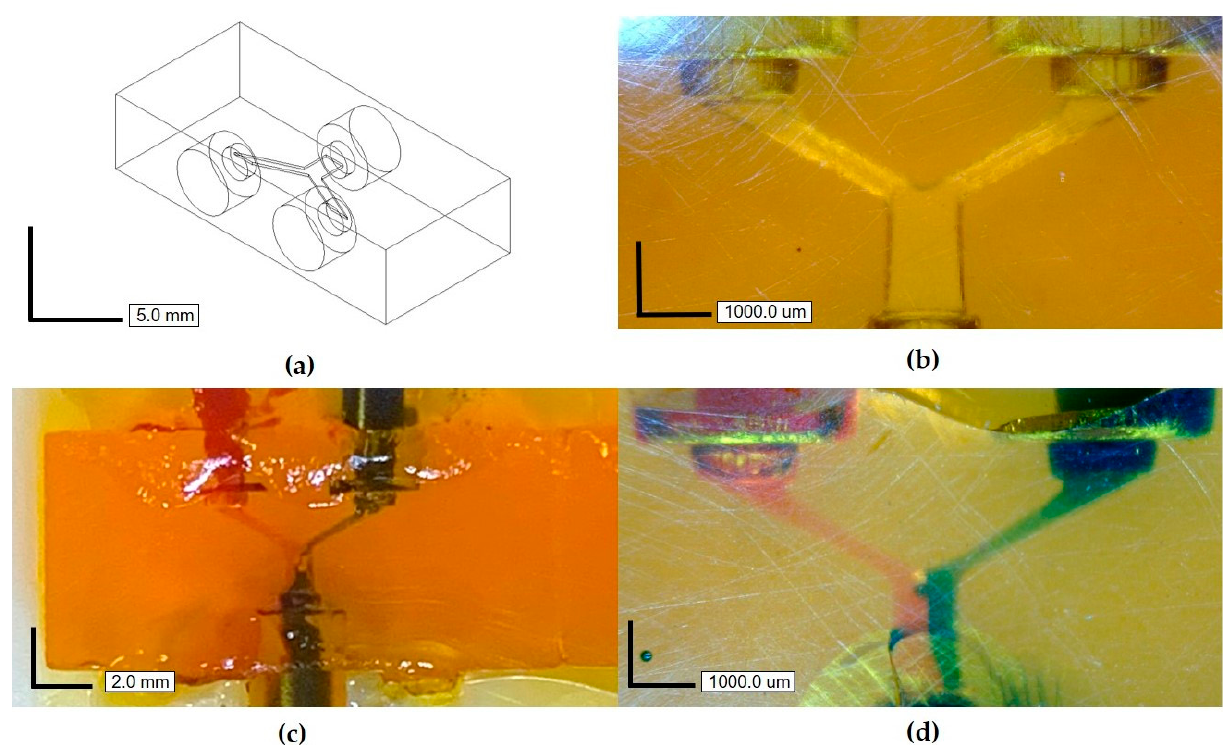
Figure 5. ( a ) A 3D CAD drawing of a microfluidic channel junction with 240 µm tall and 40 pixels wide (1080 µm) channels; ( b ) zoomed-in top view of the cleared channels in the 3D-printed structure; ( c ) top view with red- and blue-dyed DI water entering the channel junction and exiting as a purple fluid; ( d ) zoomed-in top view image showing red- and blue-dyed DI water mixing at the exit port.